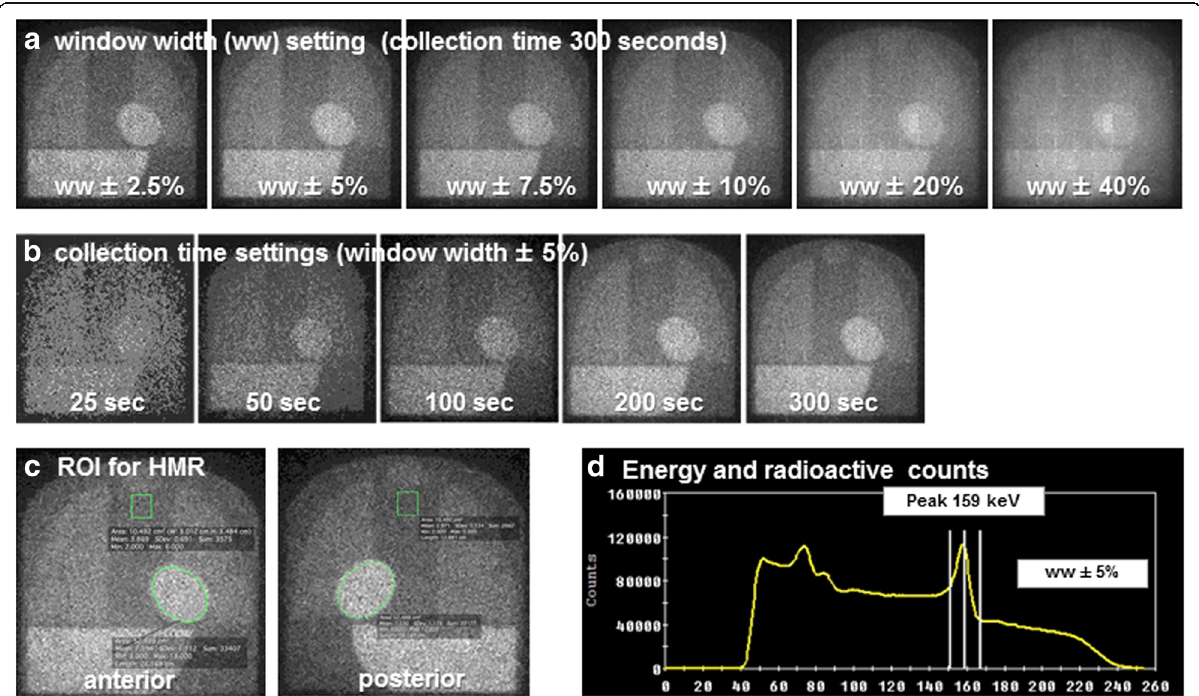
Fig. 1 Image processing and HMR calculation. a Images with different energy window widths (symmetrical, ±2.5%, 5.0%, 7.5%, 10%, 20%, and 40%) using a fixed collection time (300s). b Images with different collection times (25, 50, 100, and 200s) using a fixed window width (±5.0%). c The regions of interest (ROIs) manually set on the heart (52.5cm 2 , oval-shaped) and mediastinum (10.5cm 2 , square-shaped) in the anterior and posterior planar views. d Relationship between energy ( x -axis) and radioactive counts ( y -axis) and set energy peak ± window widths (vertical white